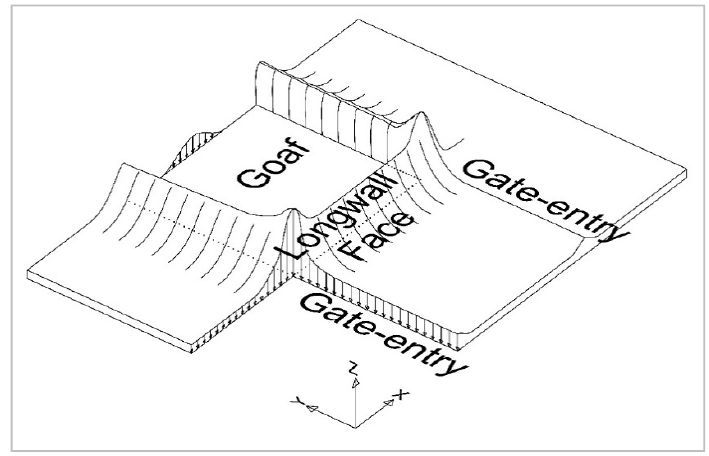
Figure 1. Vertical Stress Distribution during Longwall Panel Extraction.